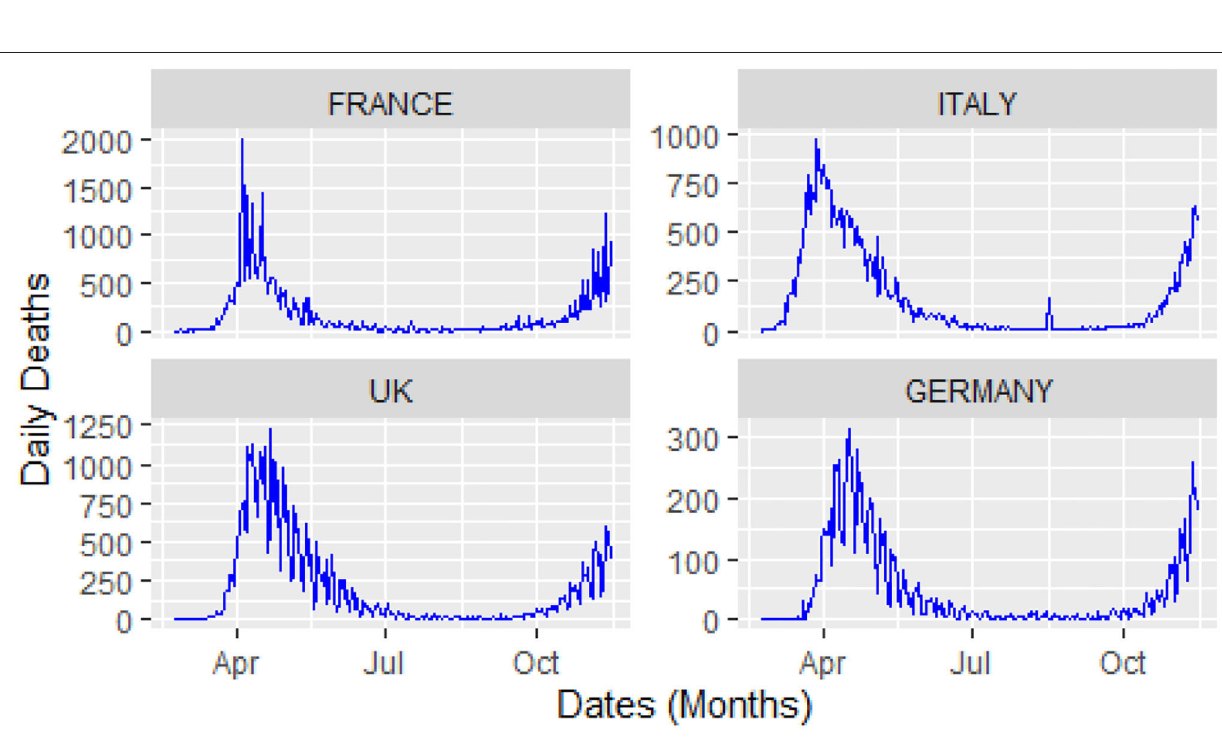
Frontiers in Public Health |